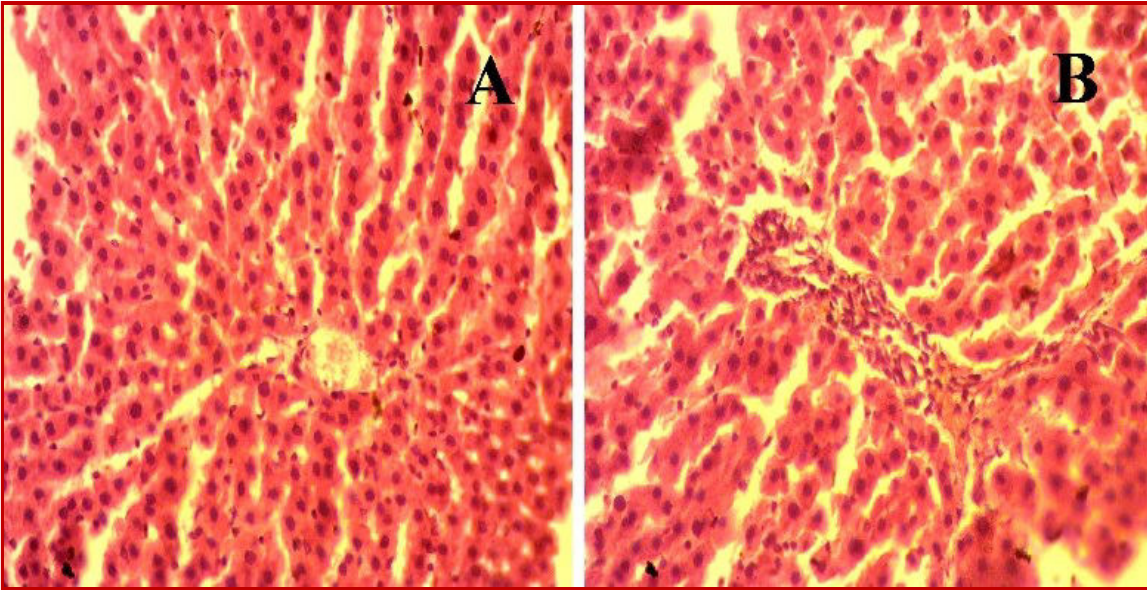
Figure 2: Hematoxylin and eosin staining showed inflammatory cell infiltration and necrosis in liver of rats treated with CCl 4 . A, Control; B, CCl